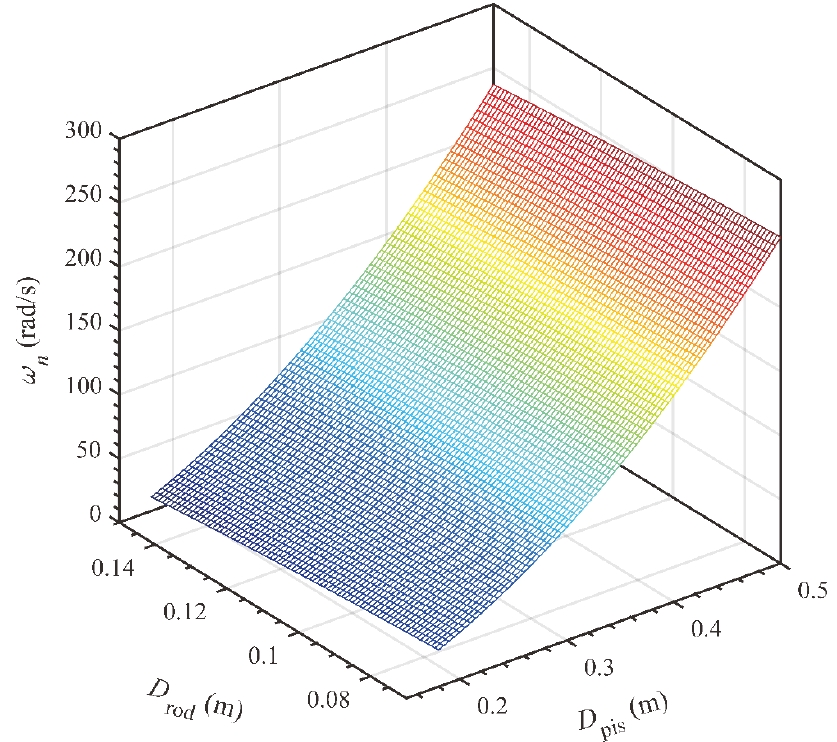
Figure 15. Effects of the piston diameter and rod diameter, D pis and D rod , on the natural annular frequency, ω n .